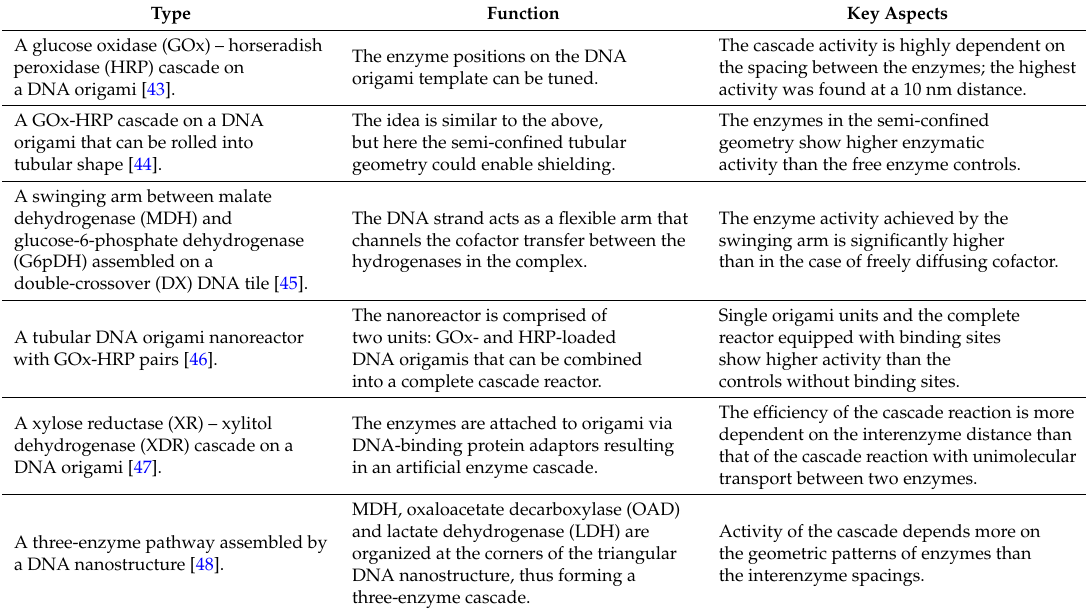
Table 1. Examples of DNA-based enzyme reactors and